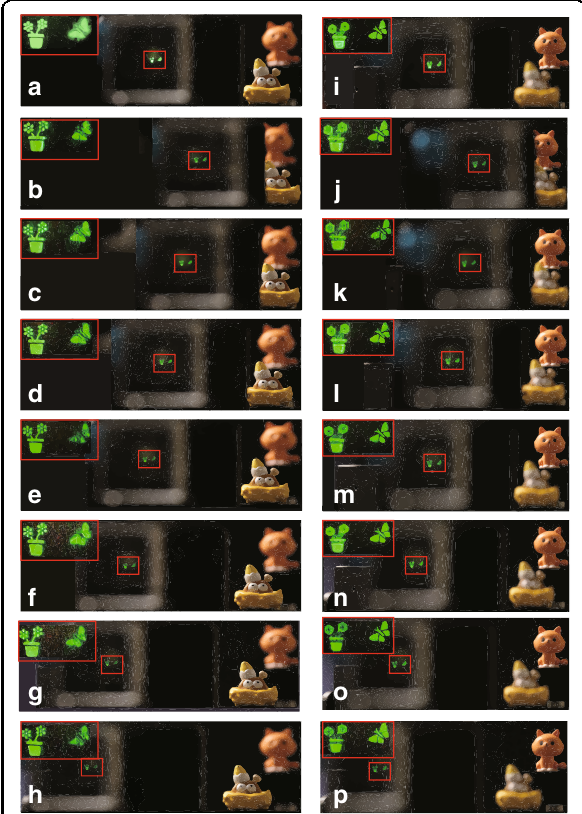
Fig. 8 Wide viewing reconstruction of 3D object. a Reproduced image of the liquid crystal grating without applied voltage when the ‘ fl ower ’ is focused. b – h Seven diffraction images focused on the ‘ fl ower ’ when the voltage is applied to the liquid crystal grating. i Reproduced image of the liquid crystal grating without applied voltage when the ‘ butter fl y ’ is focused. j – p Seven diffraction images focused on the ‘ butter fl y ’ when the voltage is applied to the liquid crystal